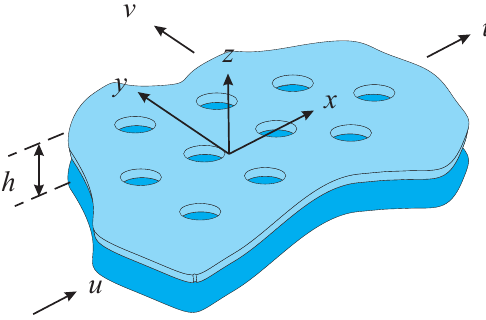
Figure 1 . General geometry of a perforated gas